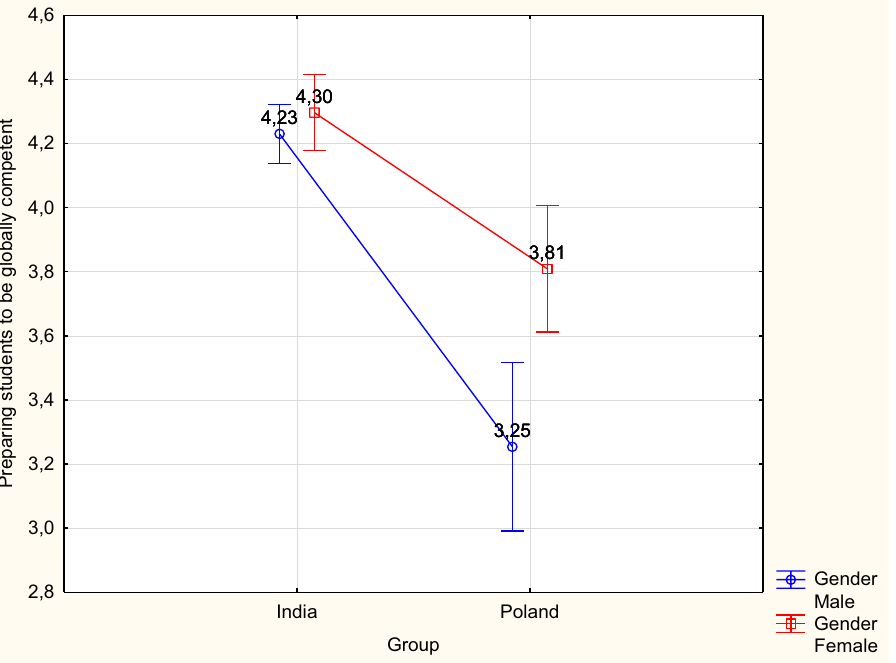
Figure 2. The mean values with a 95% confidence interval for the average value of the GC dimension by gender and